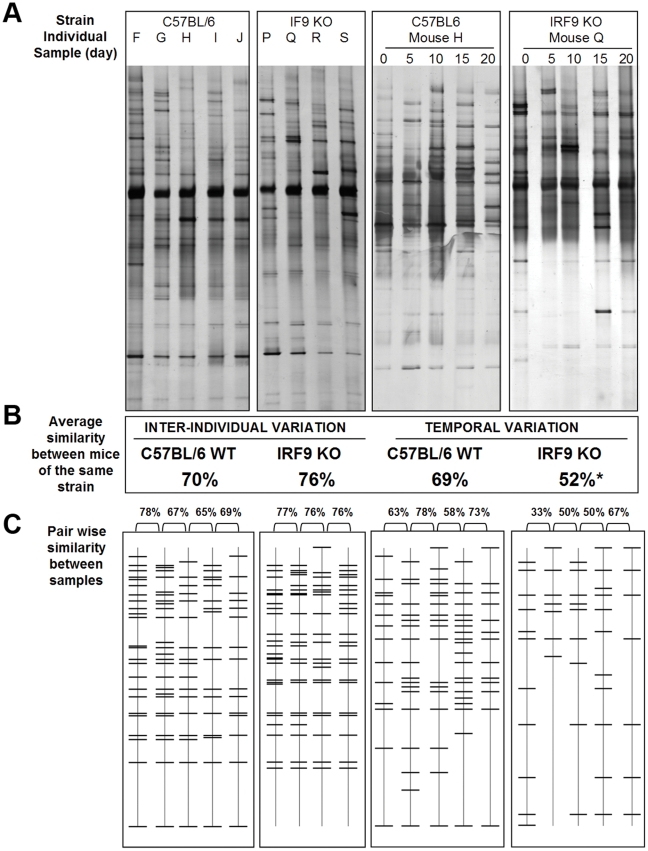
Inter-individual and within-individual temporal variation in faecal communities.(A) DGGE profiles of the overall faecal community of individual mice from the C57BL/6 and IRF9 KO mouse strains and examples of change over time when sampled at 5 day intervals for one mouse from each of the two strains. (B) Average similarity of DGGE profiles for the indicated comparisons of all mice of the same strain. (C) Schematic representation of bands detected in each profile after image analysis (see methods) and calculated pairwise similarity. * indicates significant difference at P<0.05 (see Fig 2).